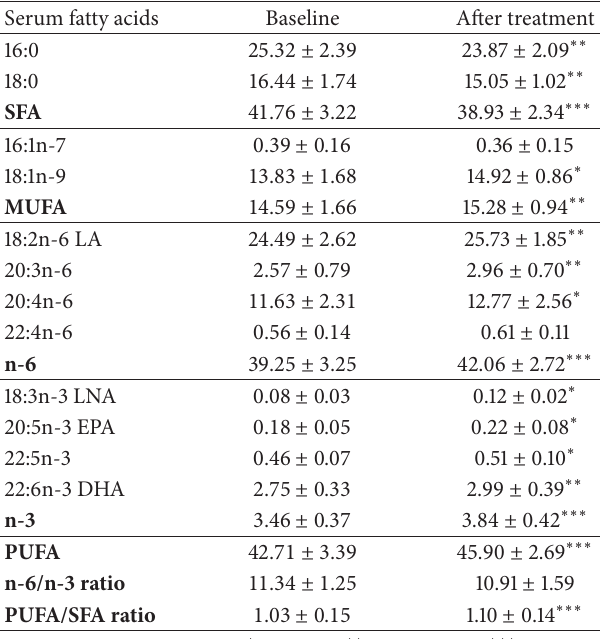
Table 3: Serum phospholipids fatty acid composition at baseline and changes induced by dietary